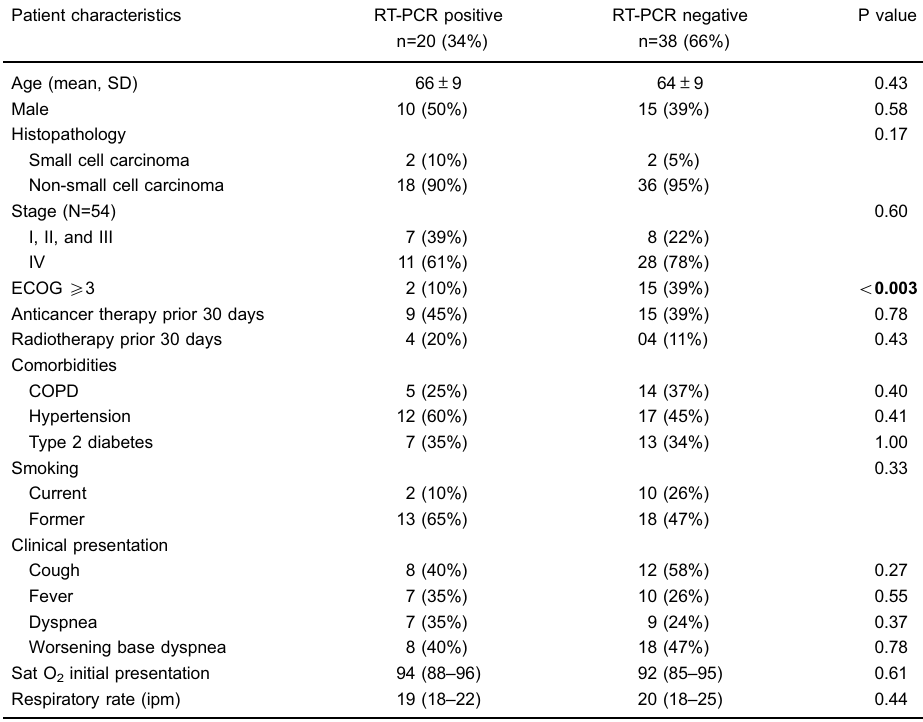
Table 2. Patient characteristics according to RT-PCR